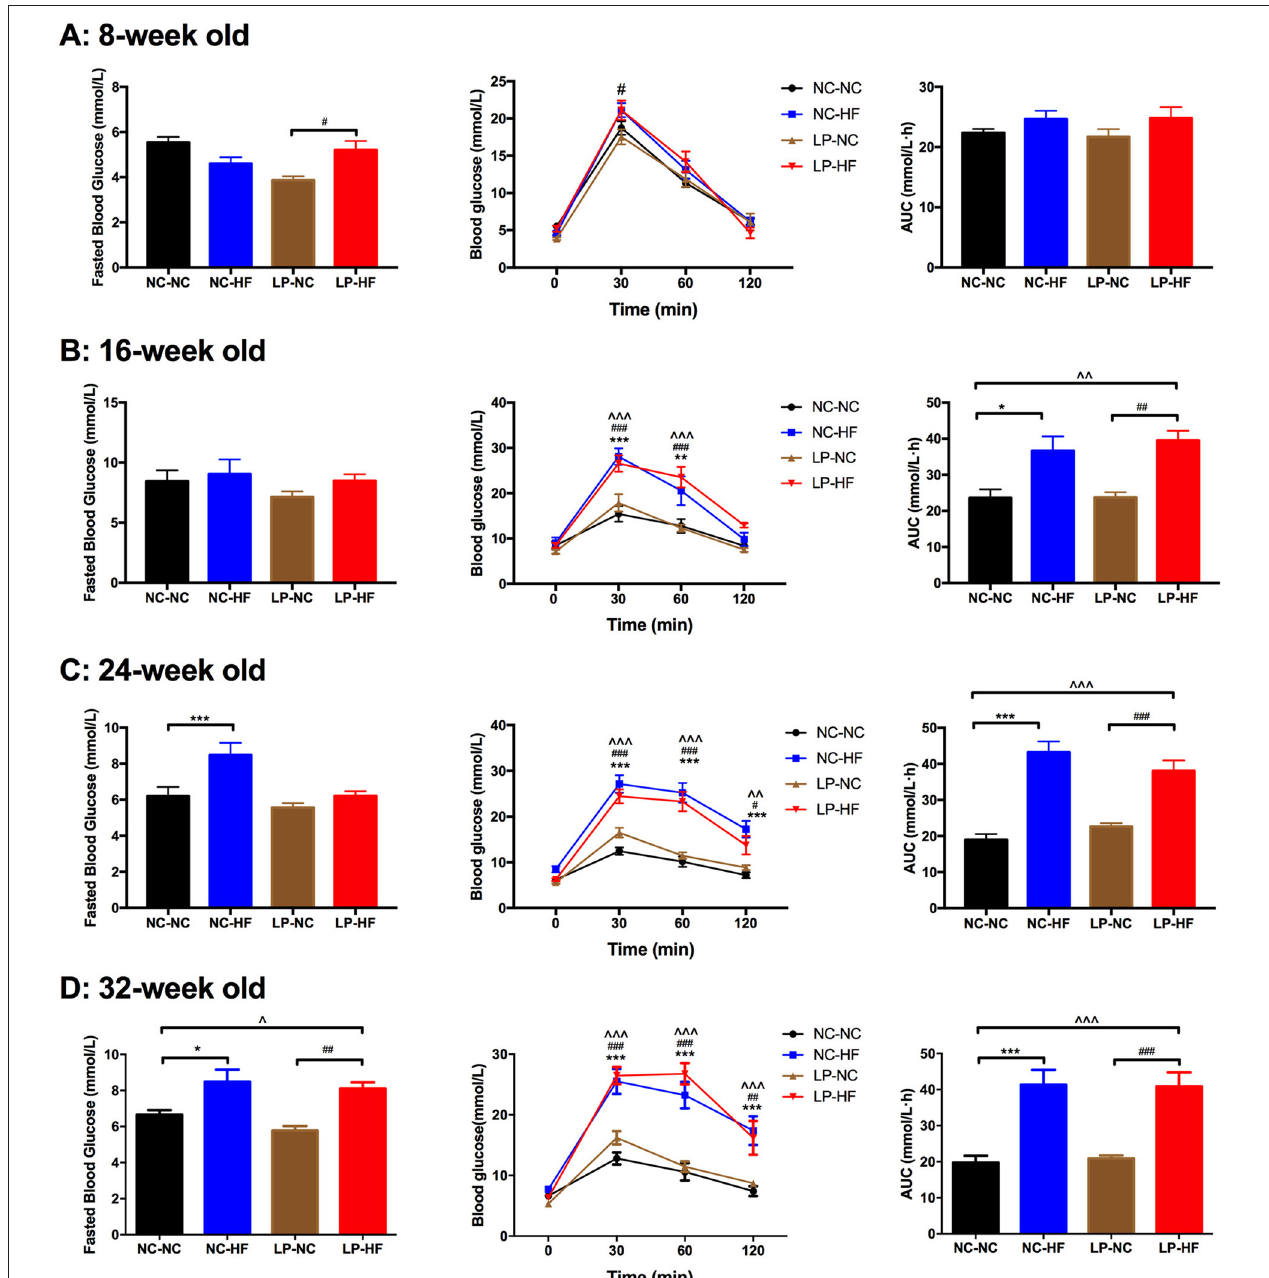
FIGURE 2 | Long-term effects of maternal protein restriction and post-weaning high-fat feeding on fasted blood glucose and glucose tolerance in offspring from 8 to 32 weeks of age. (A) Glucose metabolism at 8 weeks of age; (B) glucose metabolism at 16 weeks of age; (C) glucose metabolism at 24 weeks of age; (D) glucose metabolism at 32 weeks of age. AUC: area under the curve of ipGTT; ipGTT: intraperitoneal glucose tolerance test. Data were represented as mean ± SEM ( n = 6–8/group). * P < 0.05, ** P < 0.01 NC–HF vs. NC–NC group, *** P < 0.001 NC–HF vs. NC–NC group. ## P < 0.01, ### P < 0.001 LP–HF vs. LP–NC group. ∧∧ P < 0.01 LP–HF vs. NC–NC group, ∧∧∧ P < 0.001 LP–HF vs. NC–NC group. Diet abbreviations: NC, normal chow; LP, low protein; HF, high fat. Dam and pup diets denoted before and after the dash line, respectively.